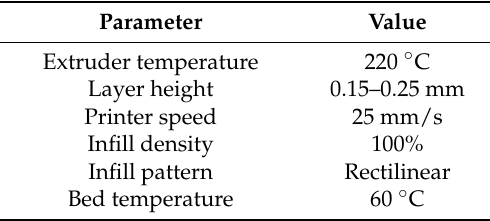
Table 1. Empirically-found printer parameters for the developed polymer-bonded compound filament (MagFil).